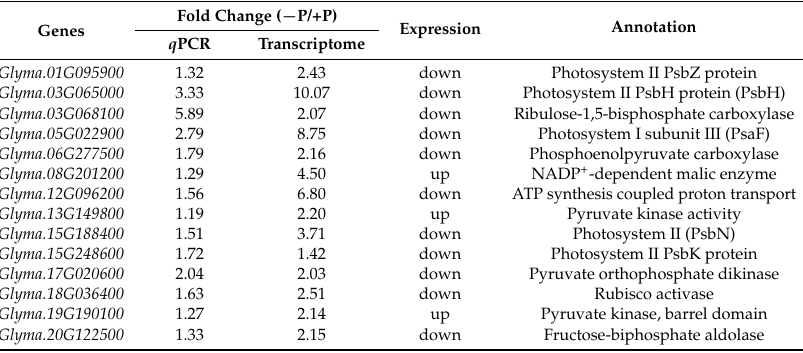
Table 2. Relative transcript levels by transcriptome and validation by q PCR of photosynthetic-related genes under different P